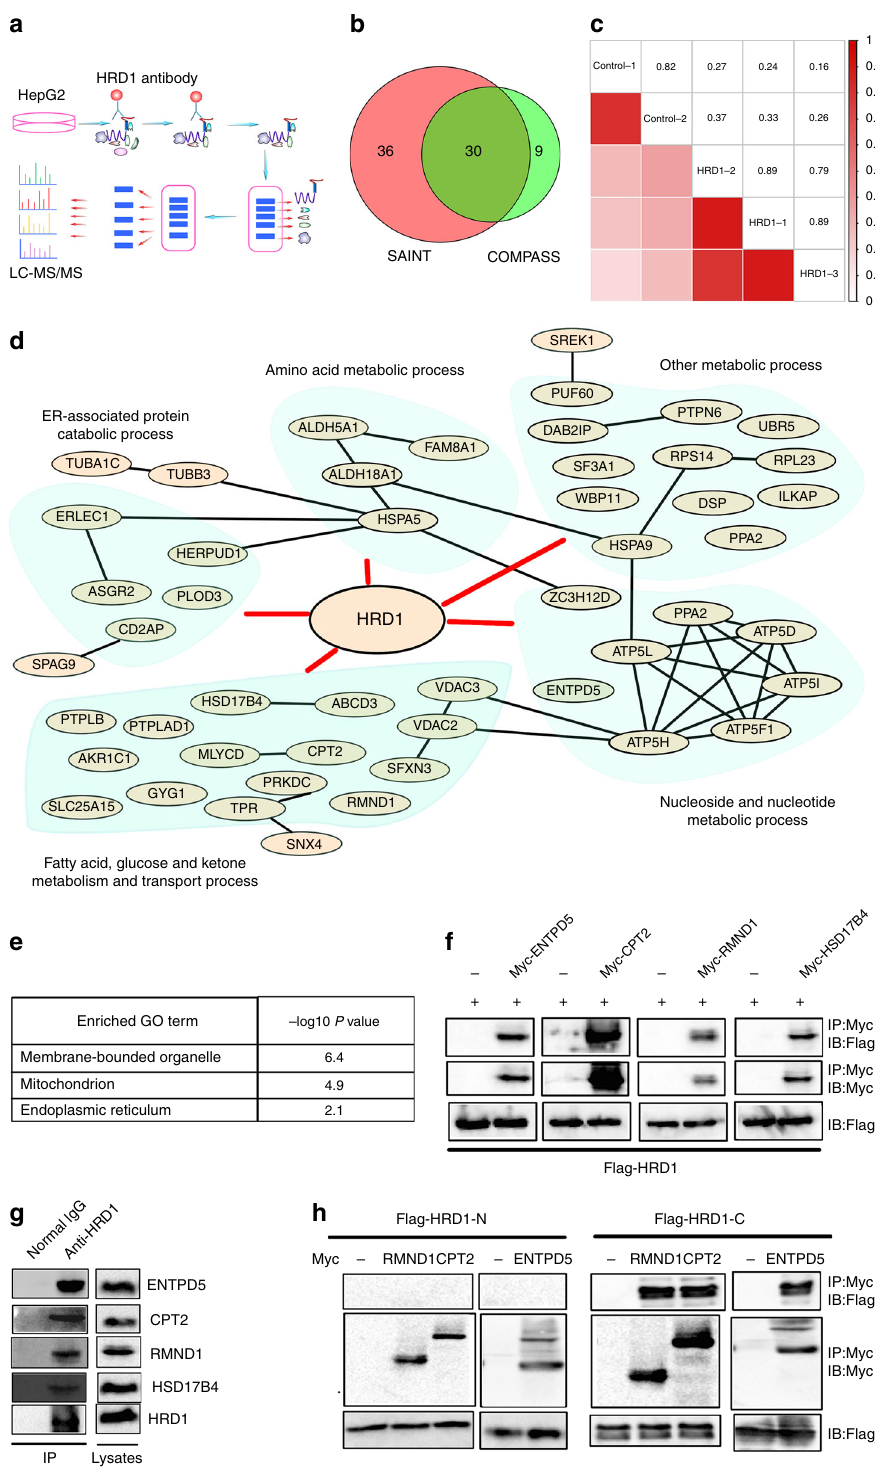
Fig. 3 Identi fi cation of potential E3 ligase HRD1-interacting protein substrates by AP-MS. a Flow chart for the proteomic identi fi cation of HRD1-binding proteins. b Venn diagram of high-con fi dence proteins derived from the COMPASS and SAINT software. c A correlation matrix based on spectral counts of each protein was constructed for the three repeats of HRD1 puri fi cation and two repeats of control samples using normal IgG. Pairwise Pearson correlation scores were measured. d Biological process analysis of the functions of HRD1-binding proteins. e GO localization analysis of the HRD1-binding proteins. f Validation of the interactions between HRD1 and potential HRD1-binding proteins from proteomic screening. g Endogenous interaction between HRD1 and screened proteins from f . h C-terminus of HRD1 mediates the interaction with CPT2, RMND1, and ENTPD5. Data are representative of three independent